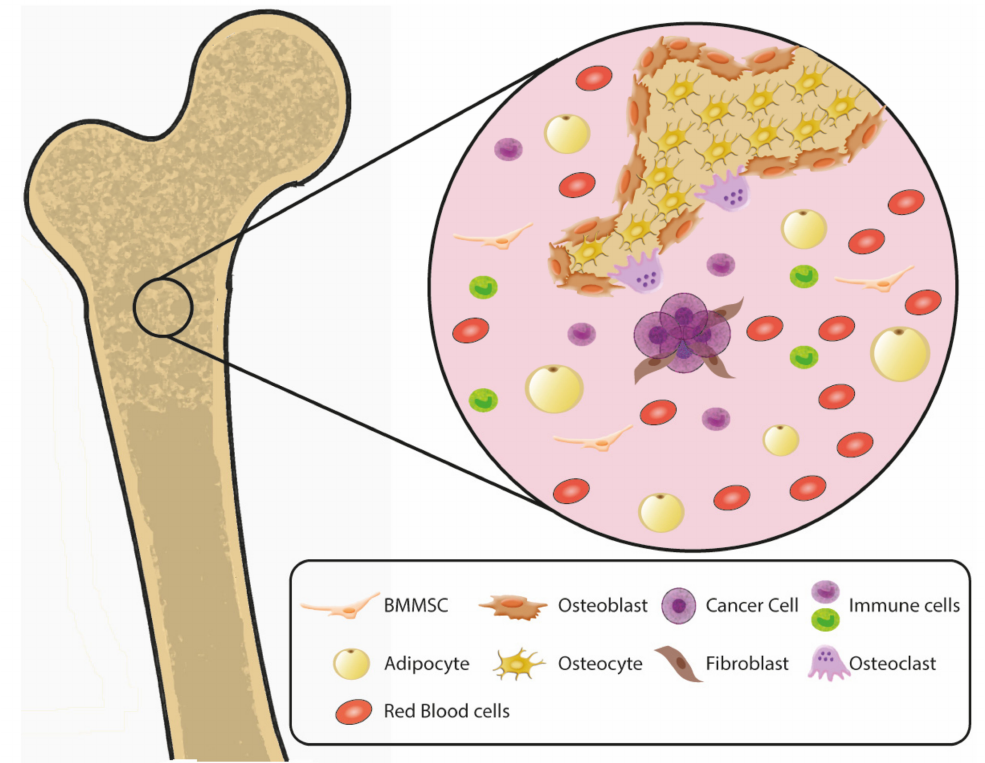
Figure 1. Multicellular composition of the bone microenvironment. The periosteal niche contains cells that regulate bone formation, deposition, and breakdown. These cell types release multiple growth factors and cytokines. The bone microenvironment is highly vascularized and immune rich, with immunosuppressive tendencies to protect the hematopoietic stem cell components. These factors generate a highly tumor-permissive environment to favor cancer cell metastasis. BMMSC = bone marrow mesenchymal stem